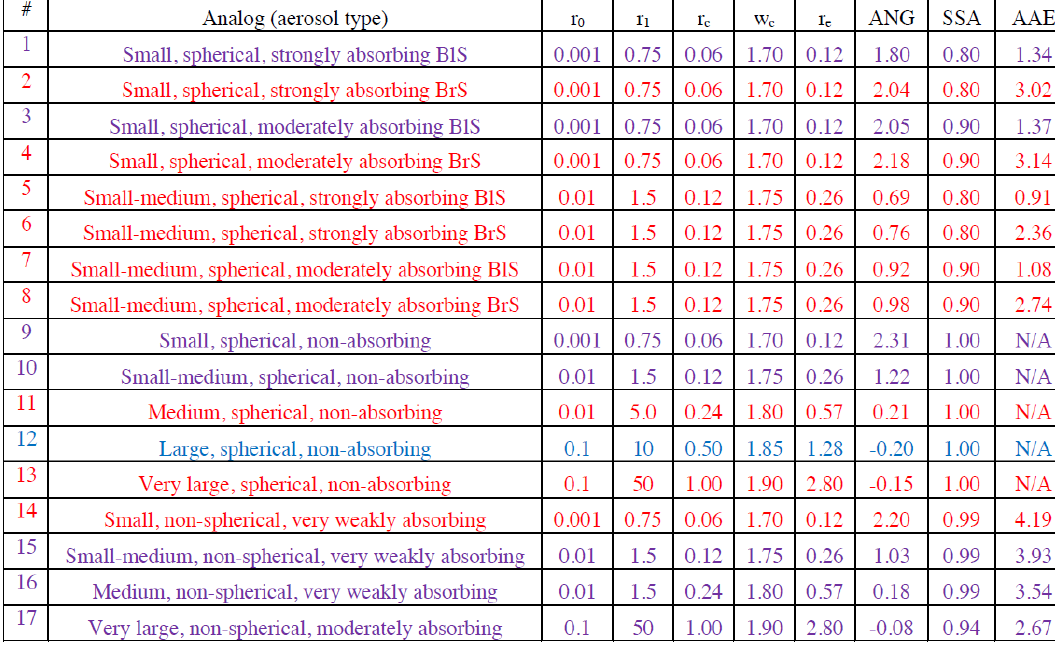
Table 1. Microphysical and optical properties of the new RA aerosol component climatology. Column 1 represents the component number, column 2 describes the aerosol analogs, and columns 3–7 represent minimum radius, maximum radius, lognormal characteristic radius, log- normal characteristic width, and effective radius (respectively). Column 8 is the Ångström exponent (calculated using all four MISR bands at 446–867nm), column 9 is 550nm single-scattering albedo (SSA), and the last column is the absorption Ångström exponent (AAE, calculated using all four MISR bands at 446–867nm). Spherical aerosol component optical properties are modeled according to Mie theory, and all components are modeled with a lognormal particle size distribution. BlS corresponds to our black-smoke optical analogs, and BrS corre- sponds to our brown-smoke optical analogs. Red-colored rows correspond to models used only in the prescribed surface retrievals, whereas the one blue-colored row corresponds to the model only used by the retrieved surface aerosol retrieval. Purple-colored rows correspond to models used in both